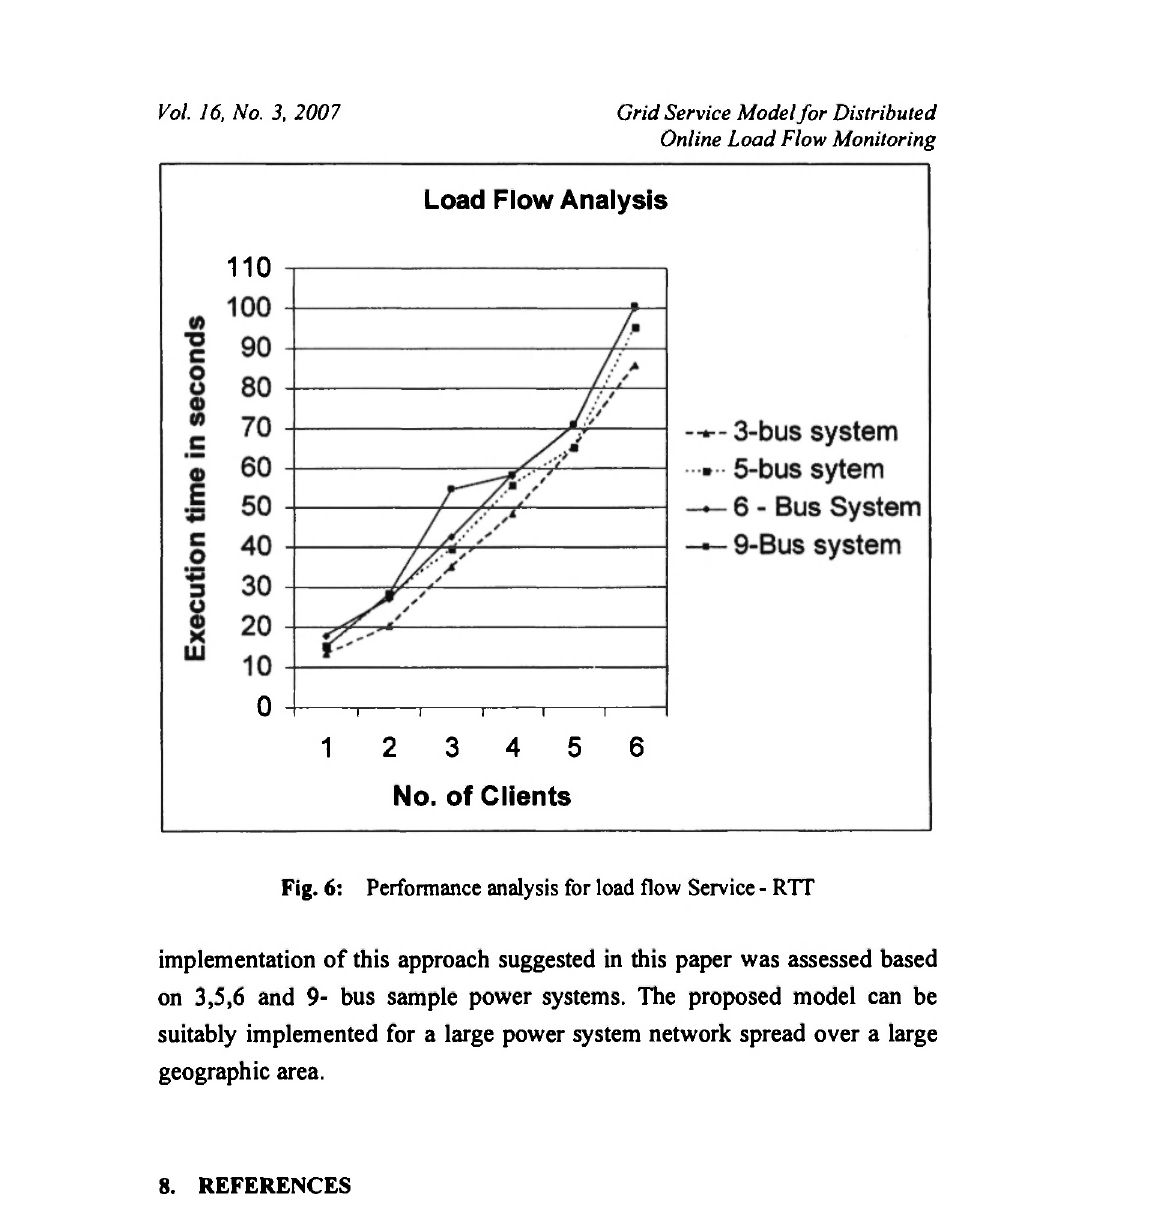
Fig. 6: Performance analysis for load flow Service -